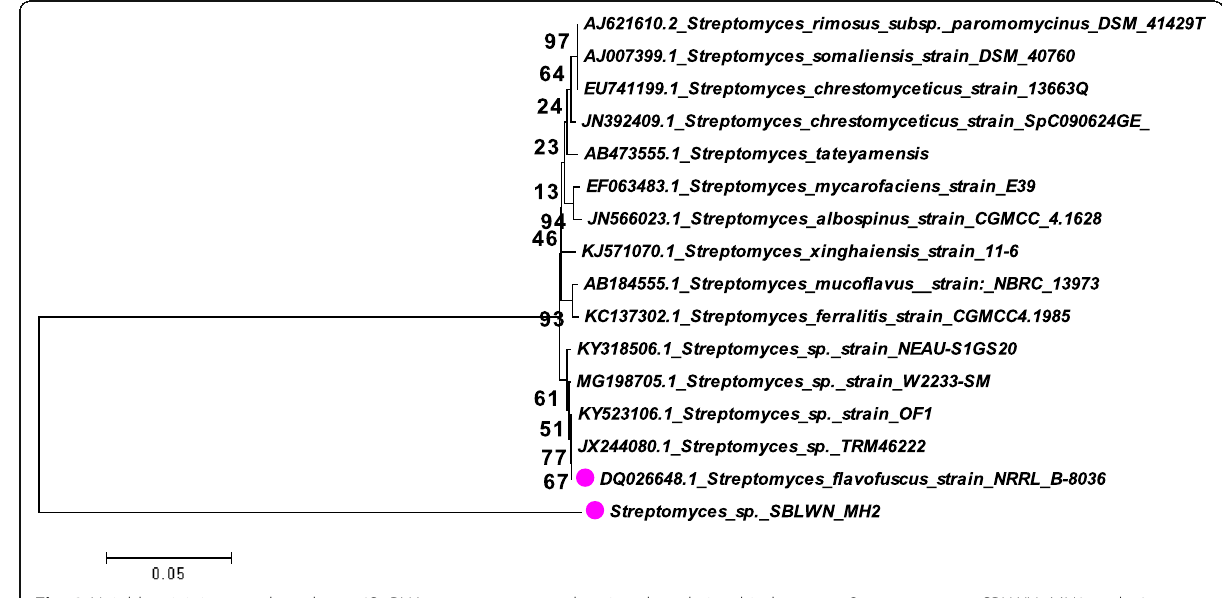
Fig. 3 Neighbor-joining tree based on 16S rRNA gene sequences showing the relationship between Streptomyces sp. SBLWN_MH2 and 19 isolates and closely related type strains of the genus Streptomyces . Bootstrap values (calculated as percentages from 500 replications) are indicated. The tree has been drawn to scale with branch lengths measured in the number of substitutions per